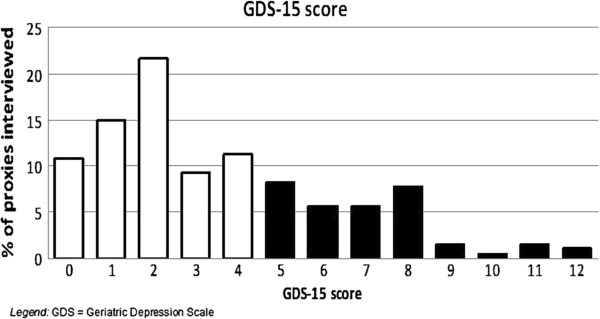
Depression levels of proxies caring for dementia patients. A score < 5 is considered normal (white bars) while a score of 5 or above is considered to reflect clinically relevant depressive symptoms (black bars).